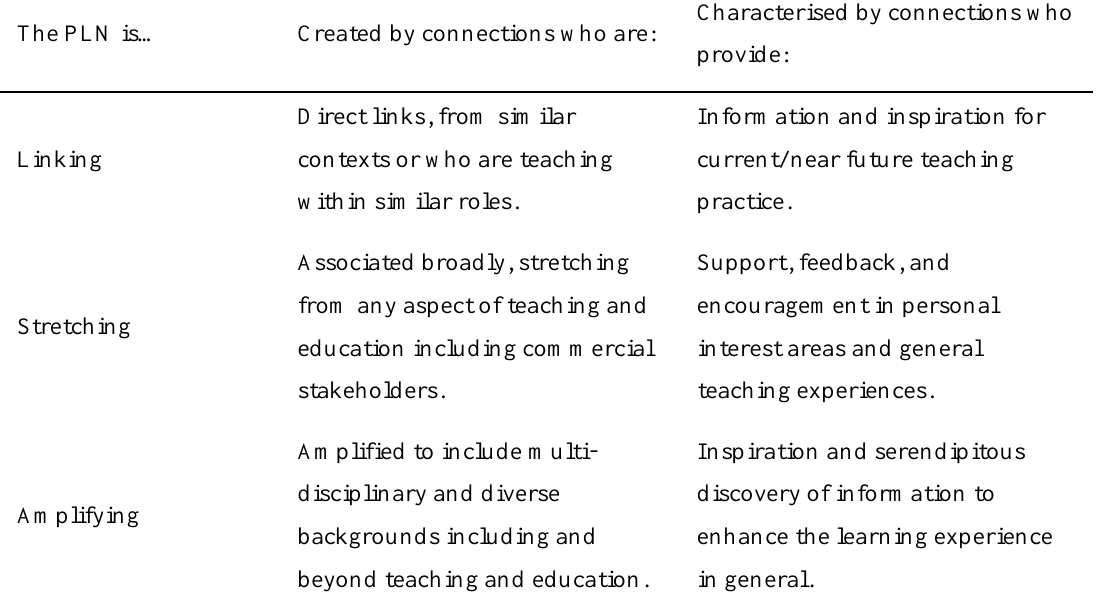
Table 5 Diverse Connections Within the PLN